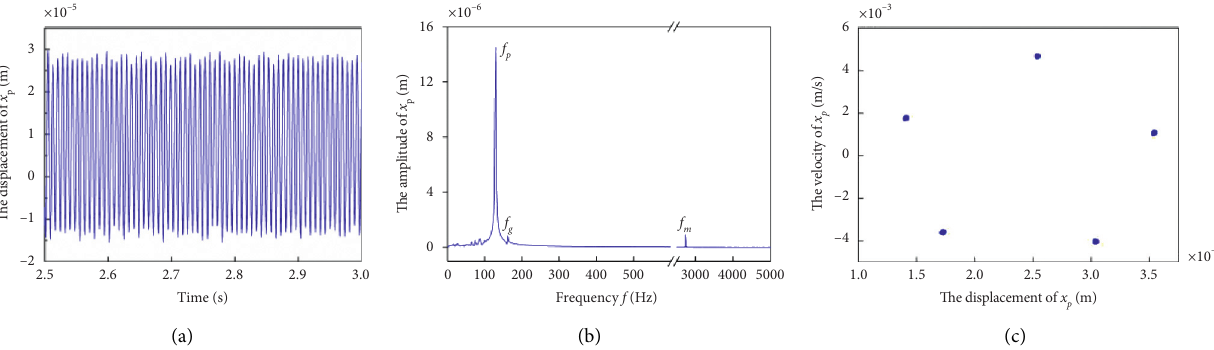
Figure 13: The dynamic vibration responses of x